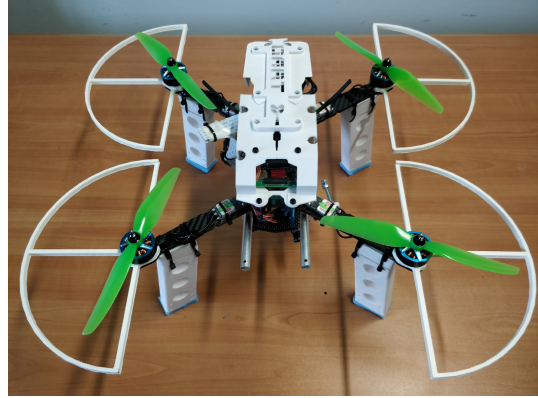
Figure 1. A picture of the Dart